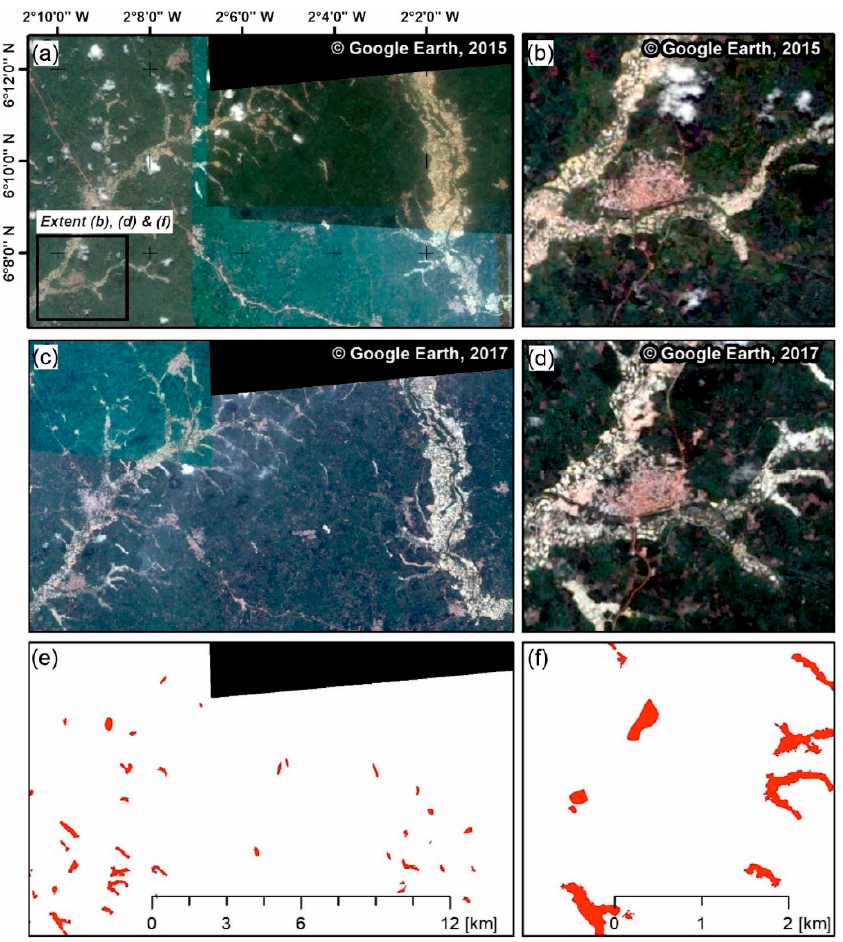
Figure 3. Reference Data from Google Earth: ( a, b ) Google Earth Imagery 2015 (© Maxar Technologies), ( c , d ) Google Earth Imagery 2017 (Image © CNES/Airbus & © Maxar Technologies) and ( e , f ) mapped changes (red polygons) between 2015 and 2017 related to mining activity.